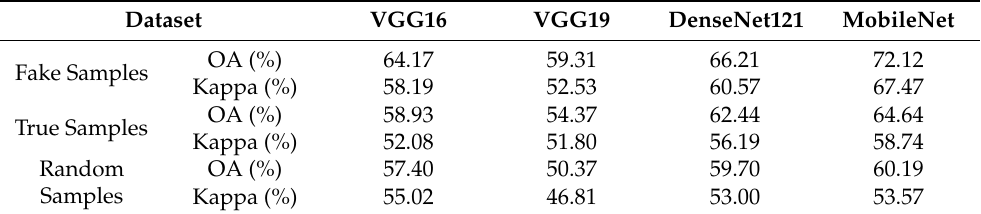
Table 3. Classification results of the different method by three training datasets in RSSCN7